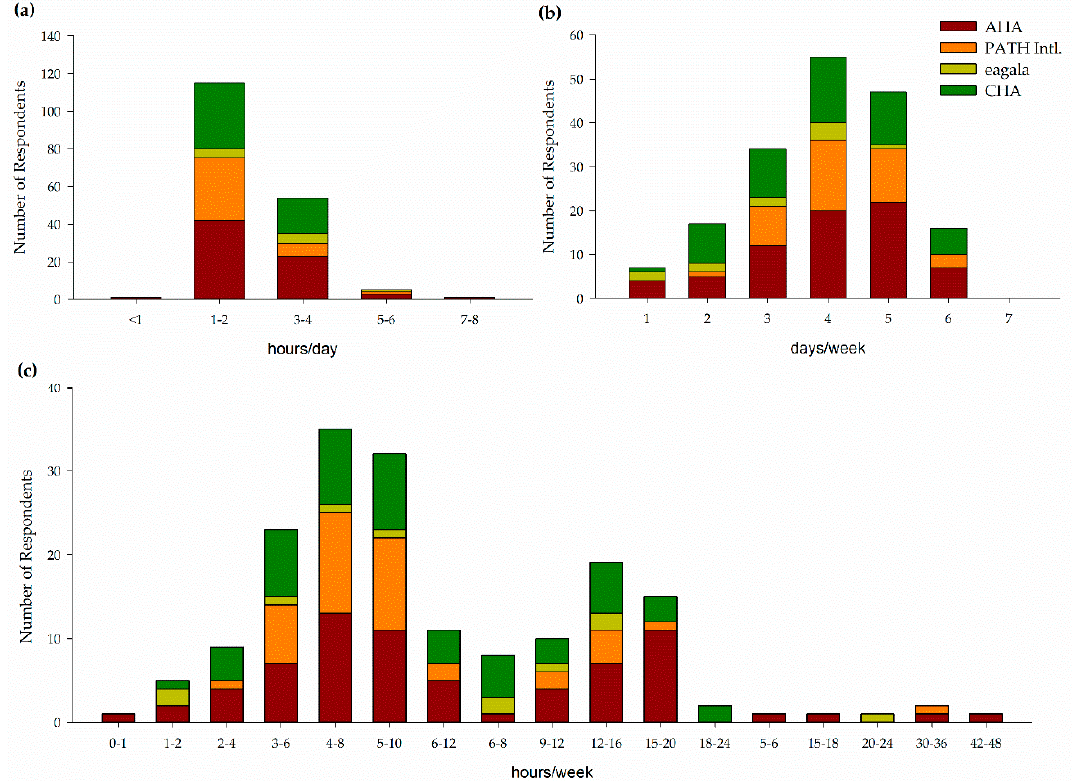
Figure 9. Workload of horses and ponies in AHA, PATH Intl, eagala, and CHA centers. ( a ) Hours per day ( b ) Days per week ( c ) Hours per week.